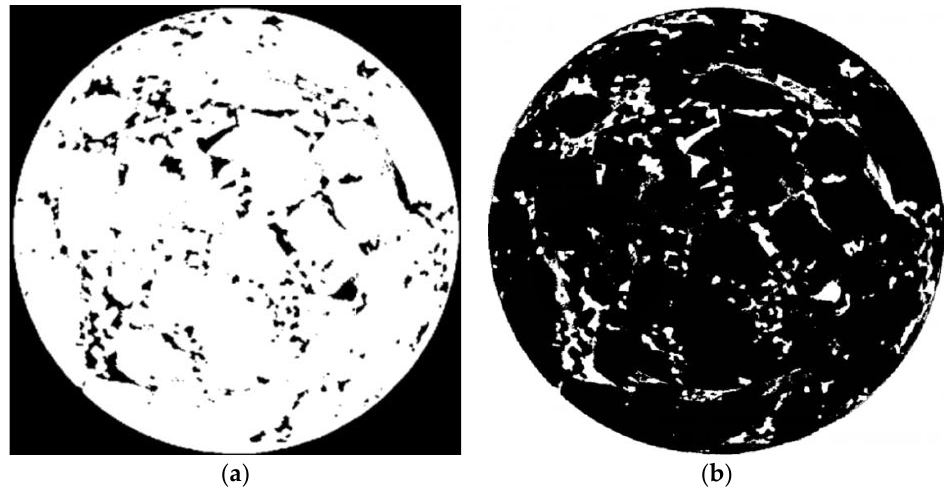
Figure 6. Void separation of CT image. ( a ) Aggregates and asphalt mortar. ( b ) Voids. (3) Separation of aggregate in CT image.